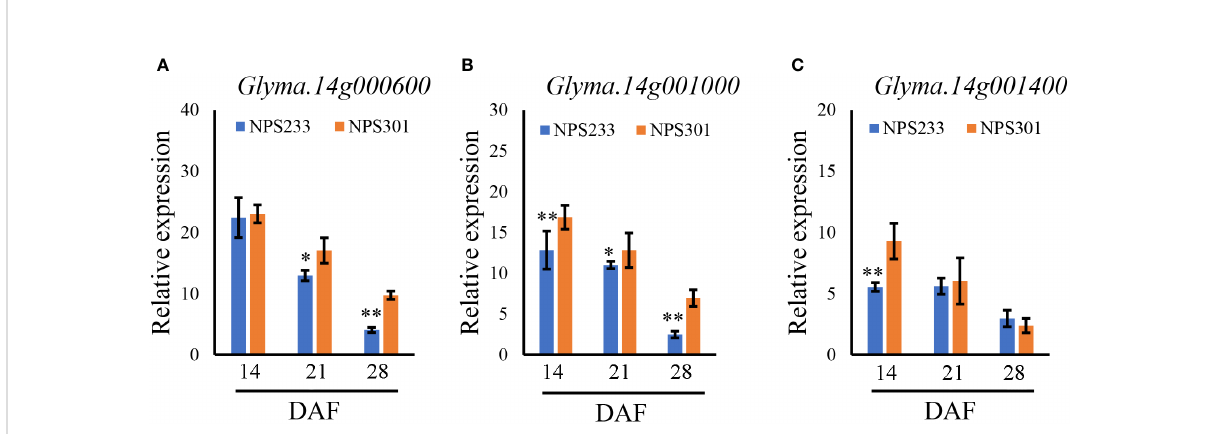
FIGURE 4 Relative expression patterns of Glyma.14g000600 (A) , Glyma.14g001000 (B) , and Glyma.14g001400 (C) during seed development in the accessions NPS233 and NPS301. Seeds were sampled at 14, 21, and 28 days after fl owering (DAF). * p < 0.05, ** p <